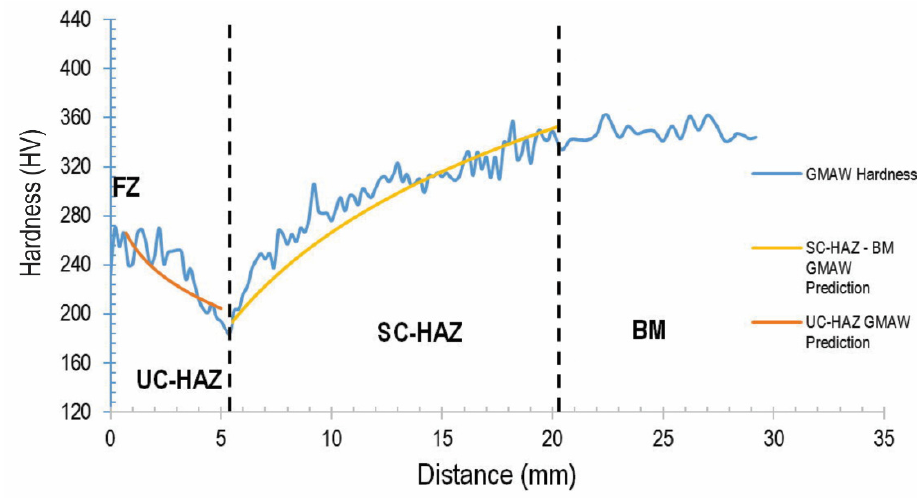
Figure 12. Hardness prediction along the HAZ of GMAW DP980 steel.